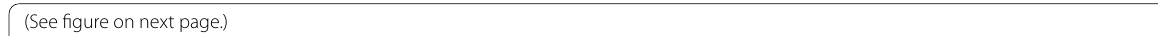
fungal isolates obtained from this =